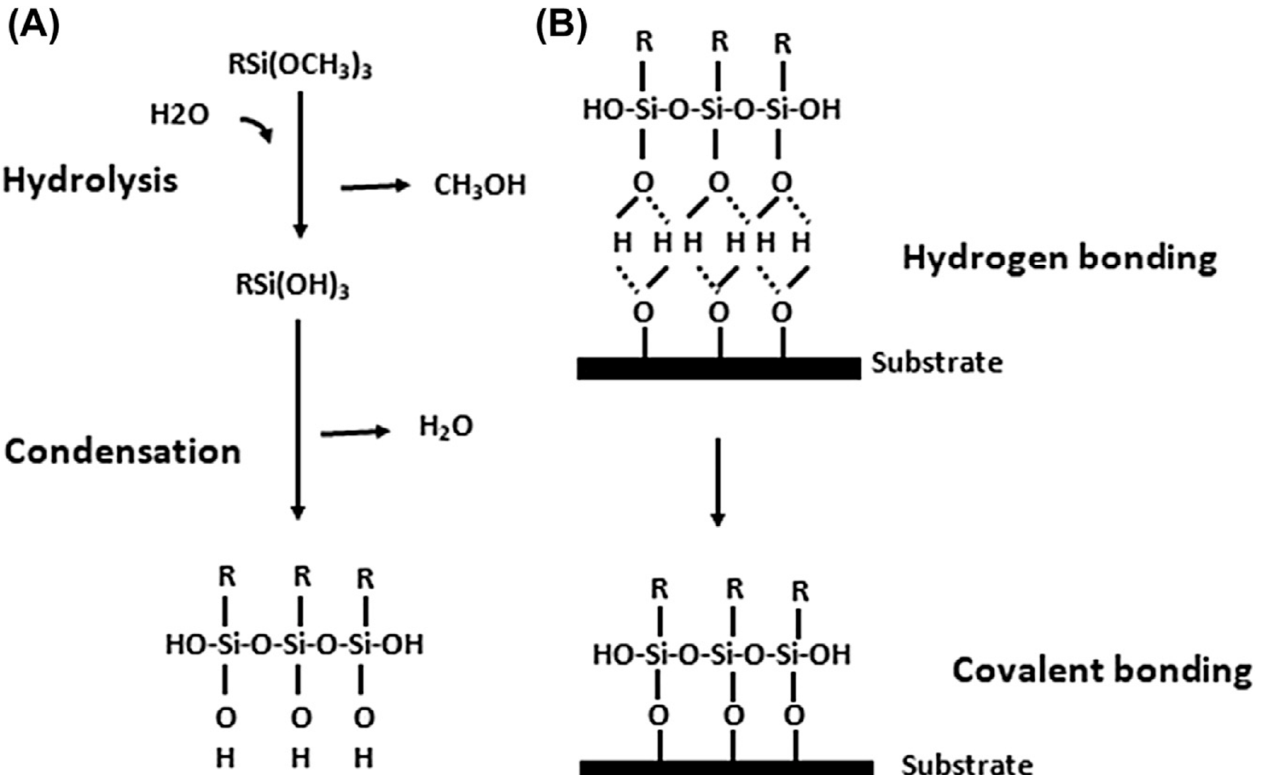
Figure 1. Hydrolysis and condensation of alkoxysilane and bonding of silanol to the metal substrate. ( A ) Hydrolysis and condensation to form oligomers in the silane solution and ( B ) adsorption to an inorganic substrate (such as ceramics or surface oxide layers on metals) by hydrogen bonding and then covalent bonding to the substrate by a condensation reaction with hydroxyl groups